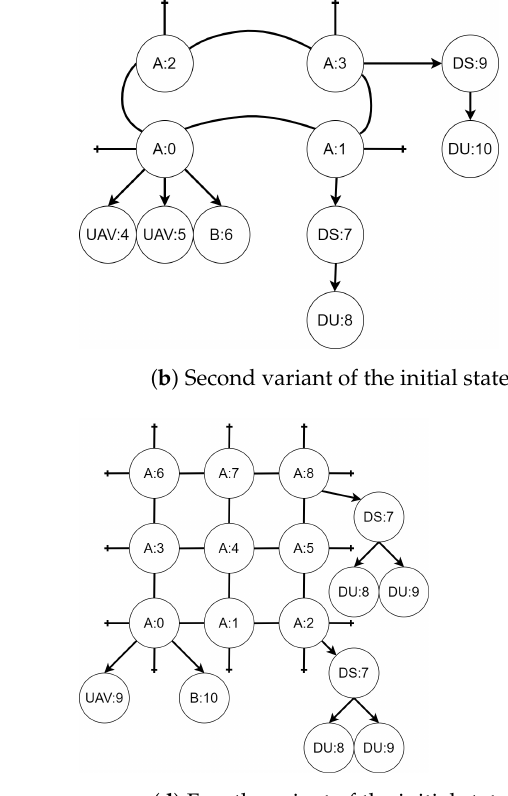
Figure 14. Initial states of scenario 2 in all variants.